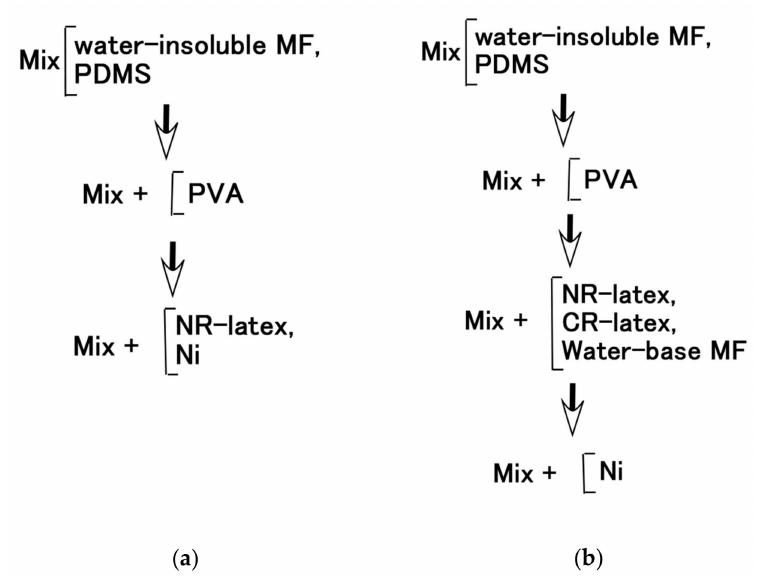
Figure 13. Mixing process for: ( a ) Figure 11; ( b ) Figure 12.